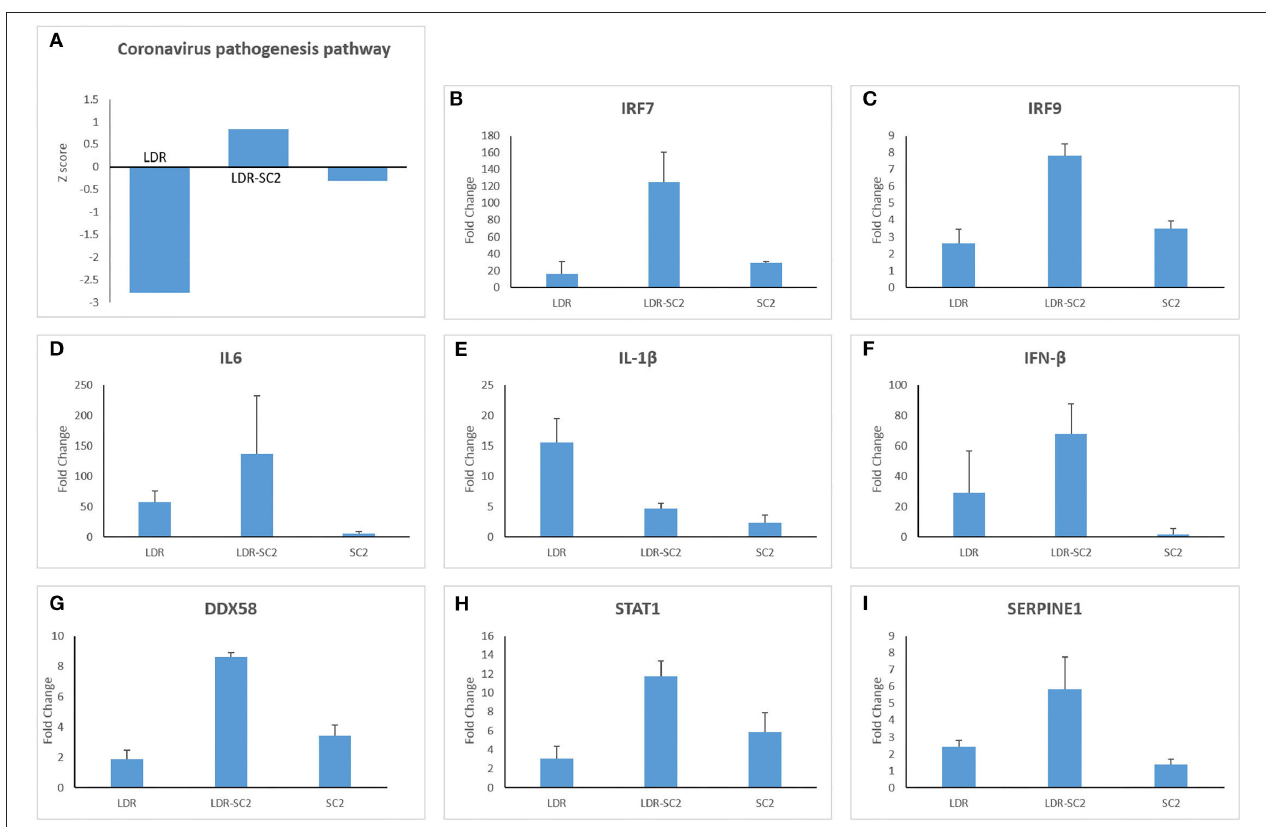
FIGURE 4 | The canonical pathway “Coronavirus pathogenesis.” (A) Biological pathway analysis revealed significant activation of the “Coronavirus pathogenesis pathway” for all 3 treatments (LDR, LDR-SC2 and SC2) presented by their Z-scores. Positive and negative values indicate overall activation or inhibition of downstream targets, respectively (B–I) . Expression levels (presented as fold change values compared to non-treated (naïve) mice group) of a subset of the expressed genes of the “Coronavirus pathogenesis pathway” in the various treatment groups presented by their Fold Change